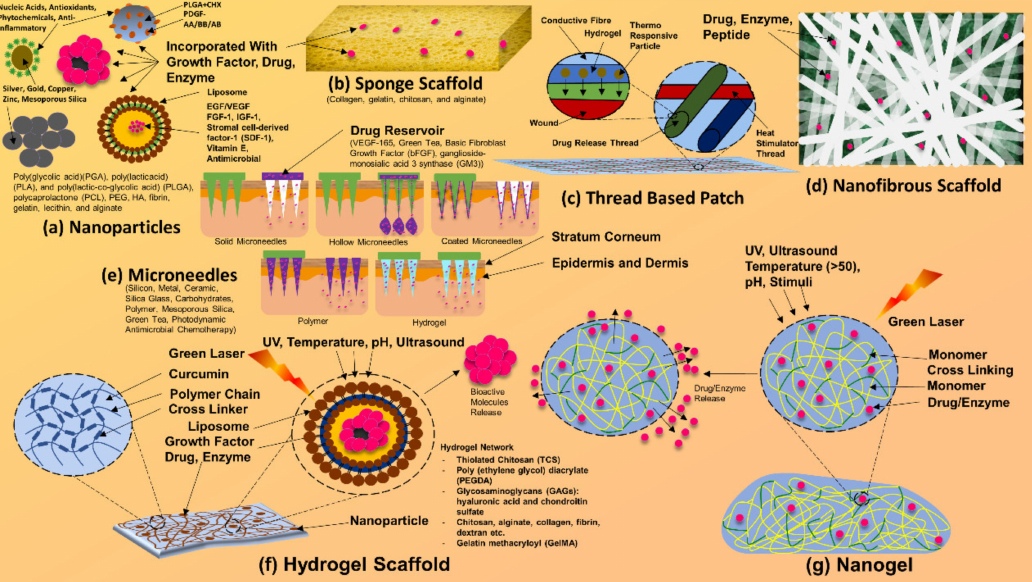
Figure 7. Composites and scaffolds of silver nanoparticles. Silver nanoparticle-based bandages, dressings, patches, and other drug delivery